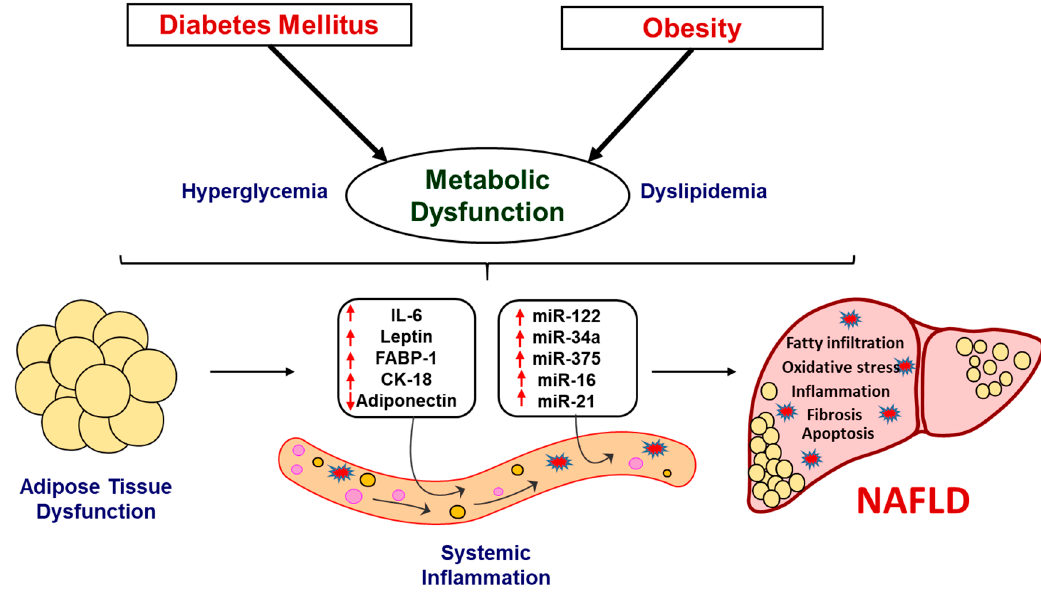
Figure 6. Schematic representation demonstrating the progression of NAFLD. The metabolic dysregulation in obese and associated diabetes in patients causes alteration in key systemic and liver enzymes. These pathological changes alter the systemic levels of key biomarkers and circulating miRNAs, which are involved in the regulation of hepatic function. The alteration in these biomarkers and miRNAs may lead to the development and progression of NASH. Hence, the utilization of panel of these specific biomarkers and miRNAs may allow tracking disease progression and, subsequently, early intervention strategies.